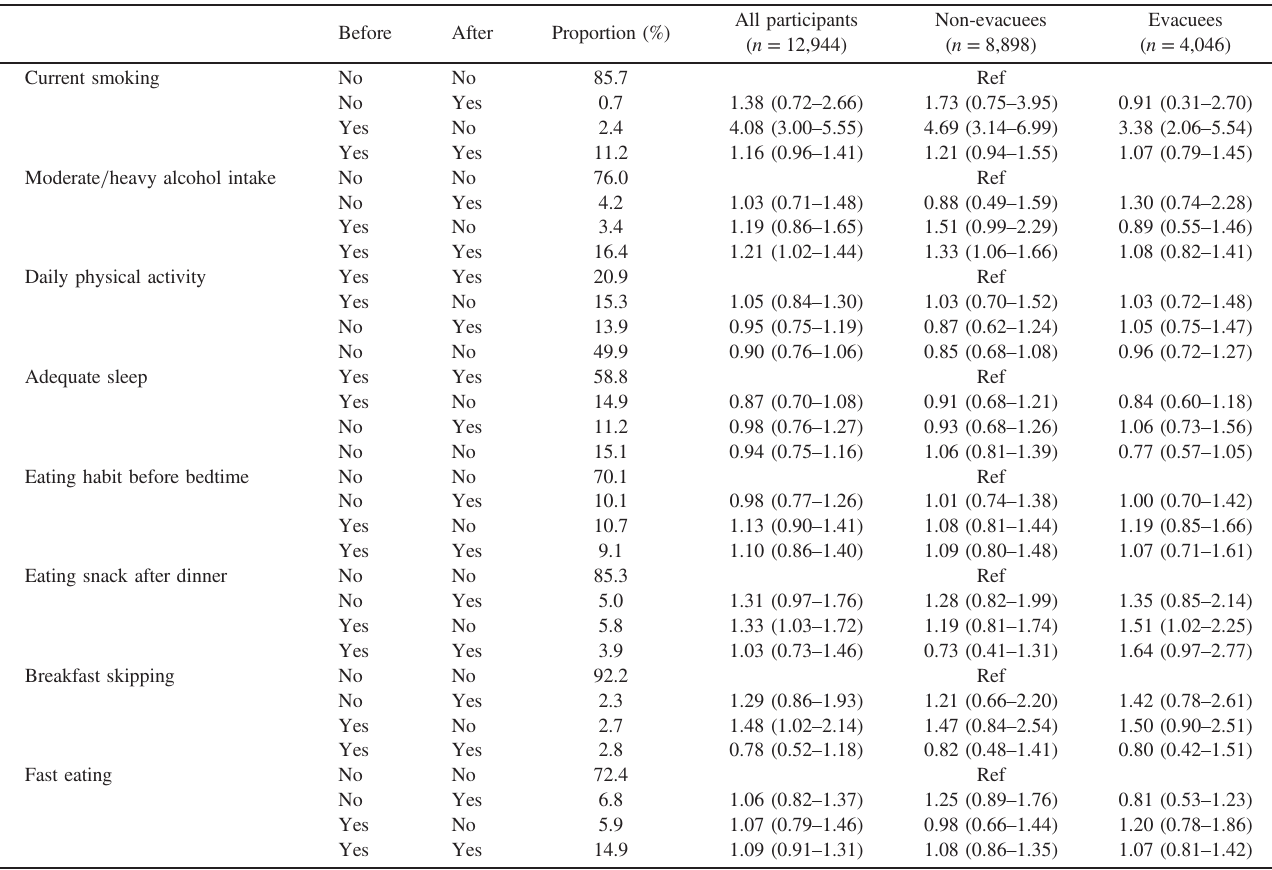
Table 3. Multivariable-adjusted odds ratios and 95% CIs of abdominal obesity after the disaster for changes in lifestyle factors among participants without abdominal obesity before the disaster strati fi ed according to evacuation All participants Before After Proportion (%) ( n = 12,944)